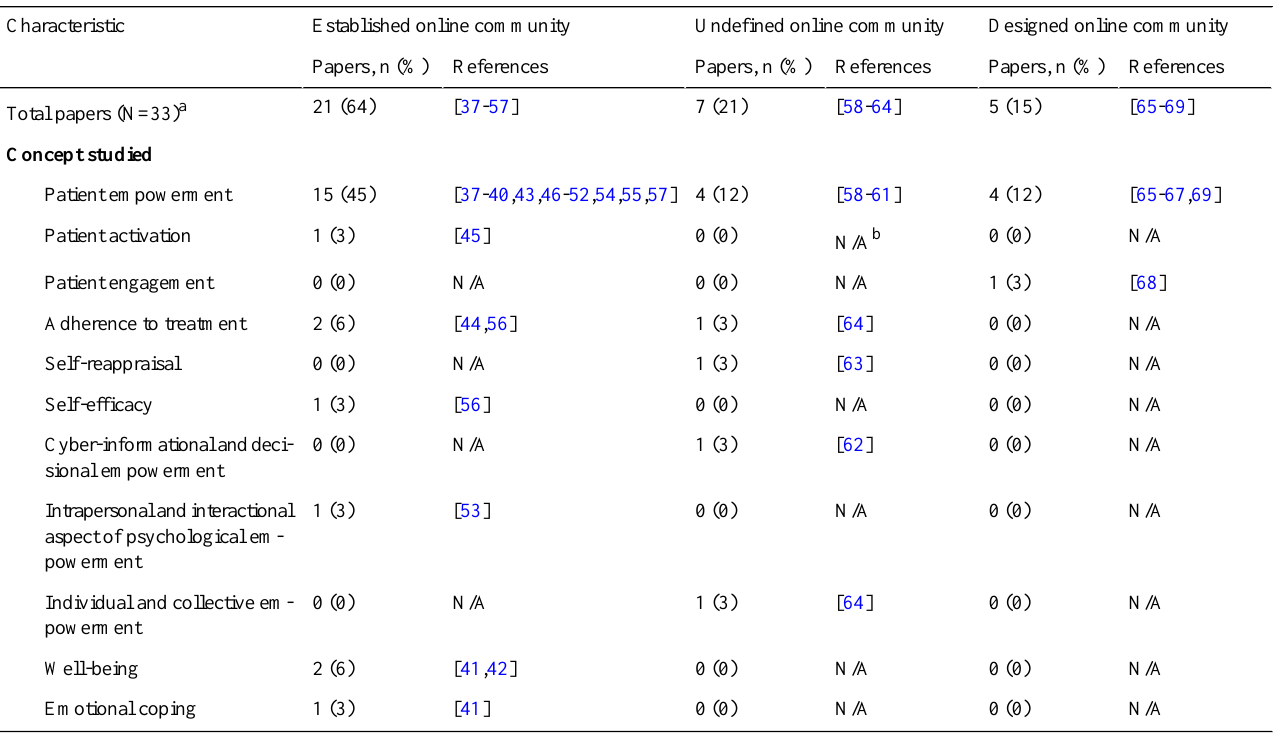
Table 1. Papers that studied patient empowerment or other related concepts.